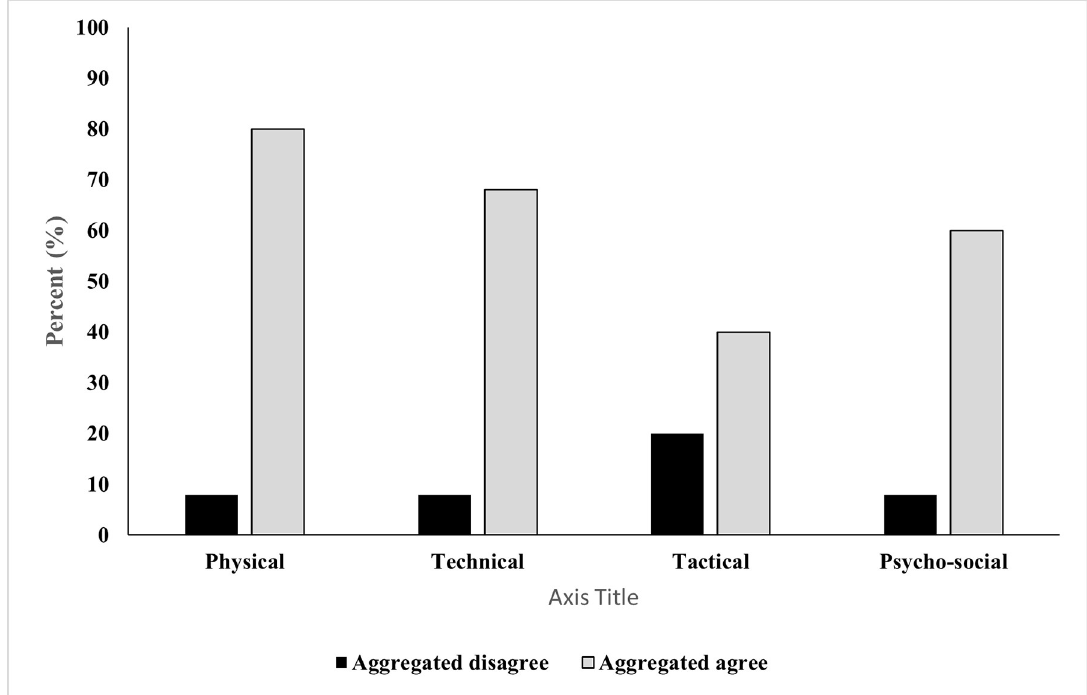
Fig 2. Percentage distribution of practitioner aggregated (i.e., sum of strongly disagree and disagree; sum of strongly agree and agree) perceived agreement (Black–Disagree; Grey–Agree) of whether they feel bio-banding enhances the assessment of physical, technical, tactical and psycho-social characteristics of academy soccer players.